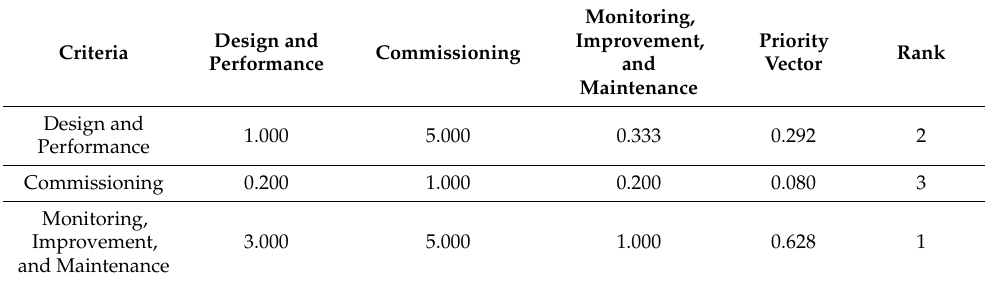
Table 9. Ranking of criteria for energy efficiency (EE)